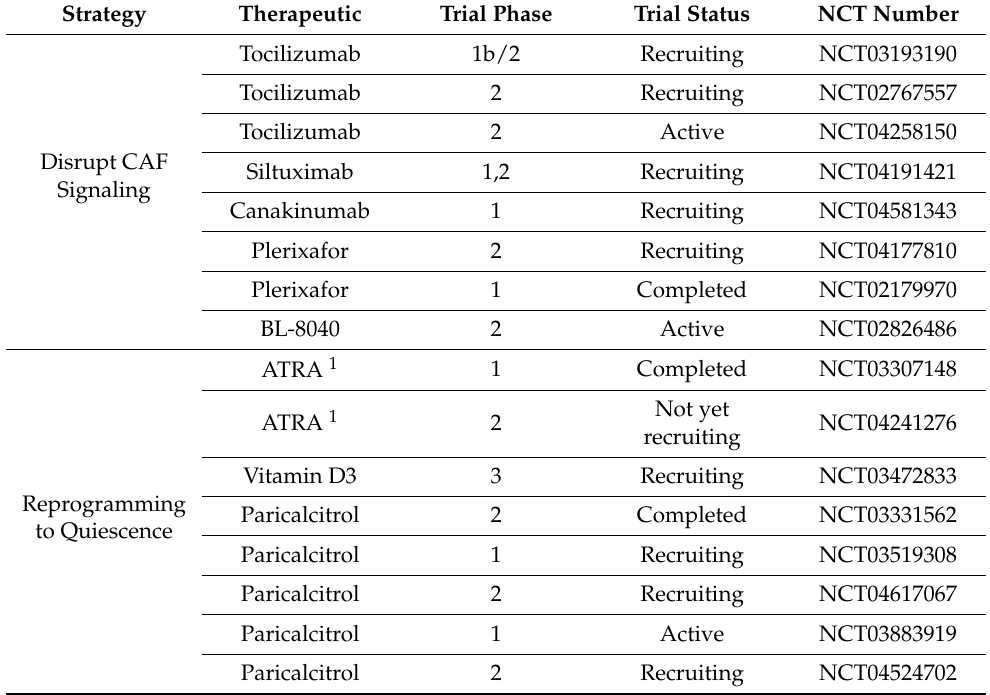
Table 1. Clinical Trials Targeting Fibroblasts in